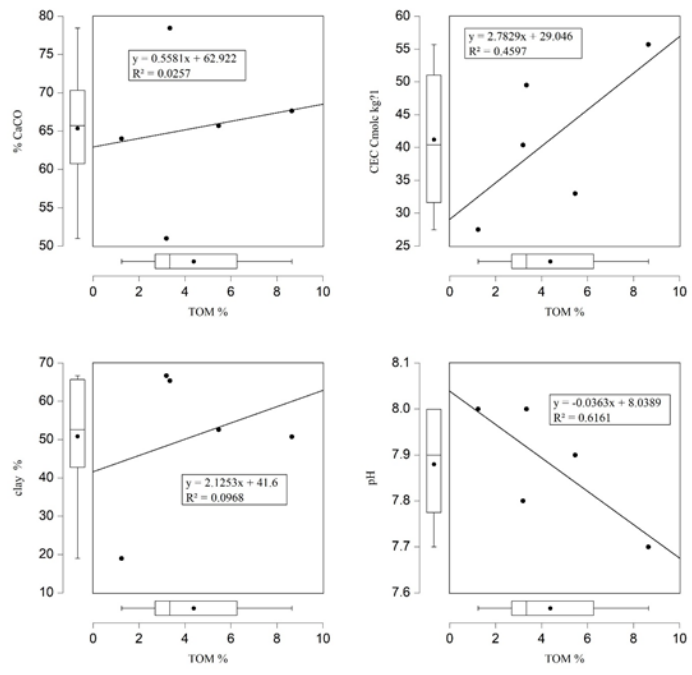
Figure 5. Scatter plot between some soil characteristics and TOM in agricultural